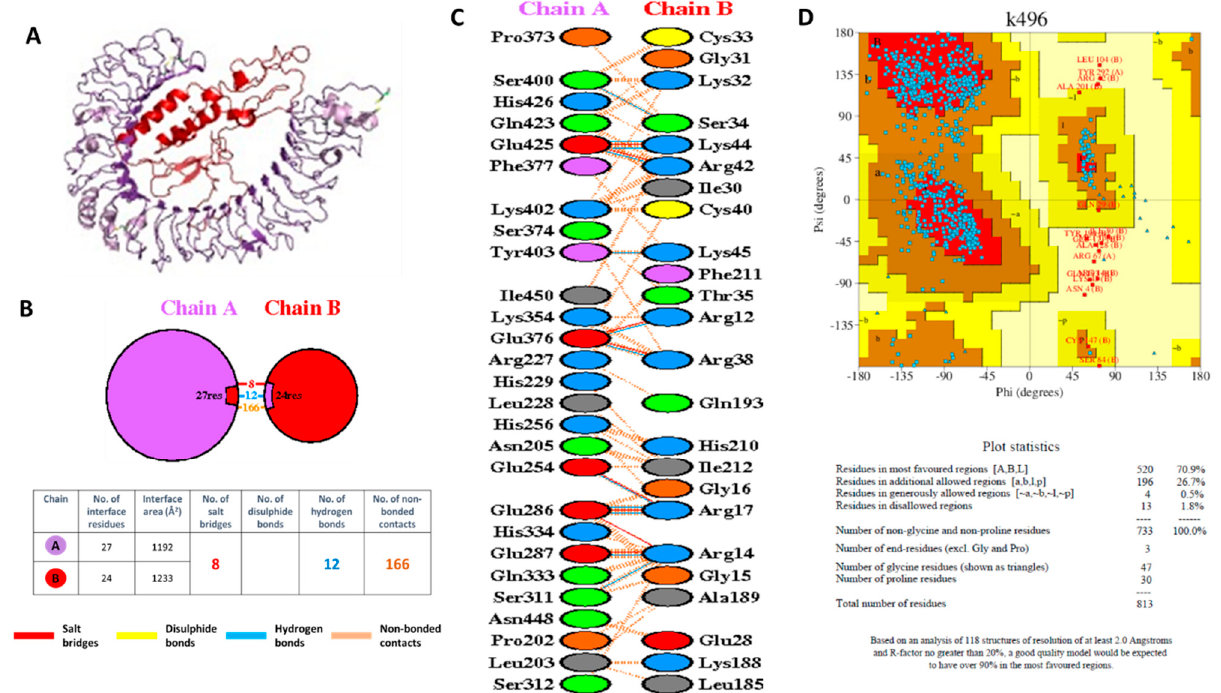
Figure 9. Interaction analysis of the VC and TLR4. ( A ) The tertiary structure model of the complex between TLR4 (purple) and the VC (red). ( B ) Diagram of interaction between the VC and TLR4 (red = salt bridges, blue = H-bonds, striped line = non-bonded contacts). ( C ) Residues involved in forming the complex. ( D ) Ramachandran plot of the interaction model showing the number of residues in the most favored region and less favored